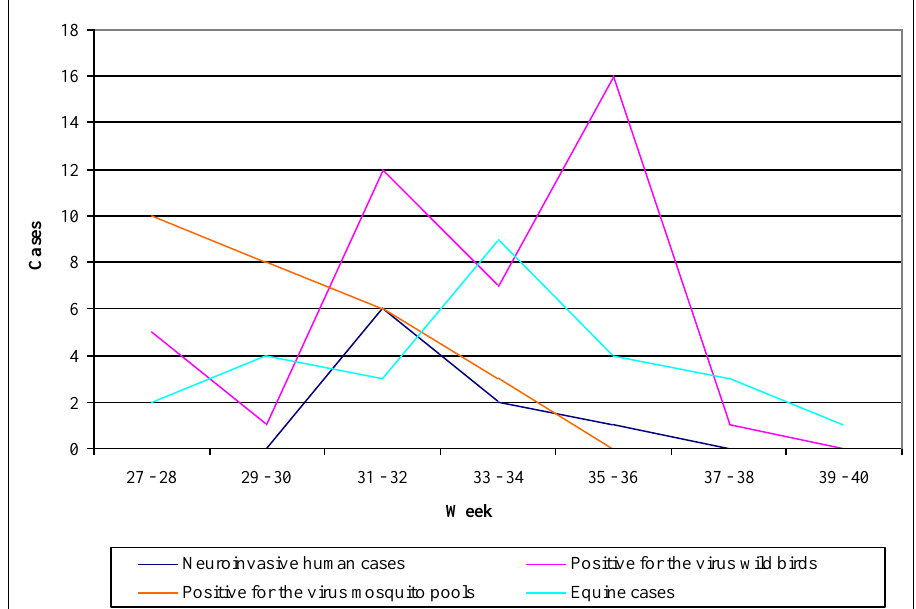
Figure 13. Surveillance data in Emilia- Romagna, 27th–40th week,